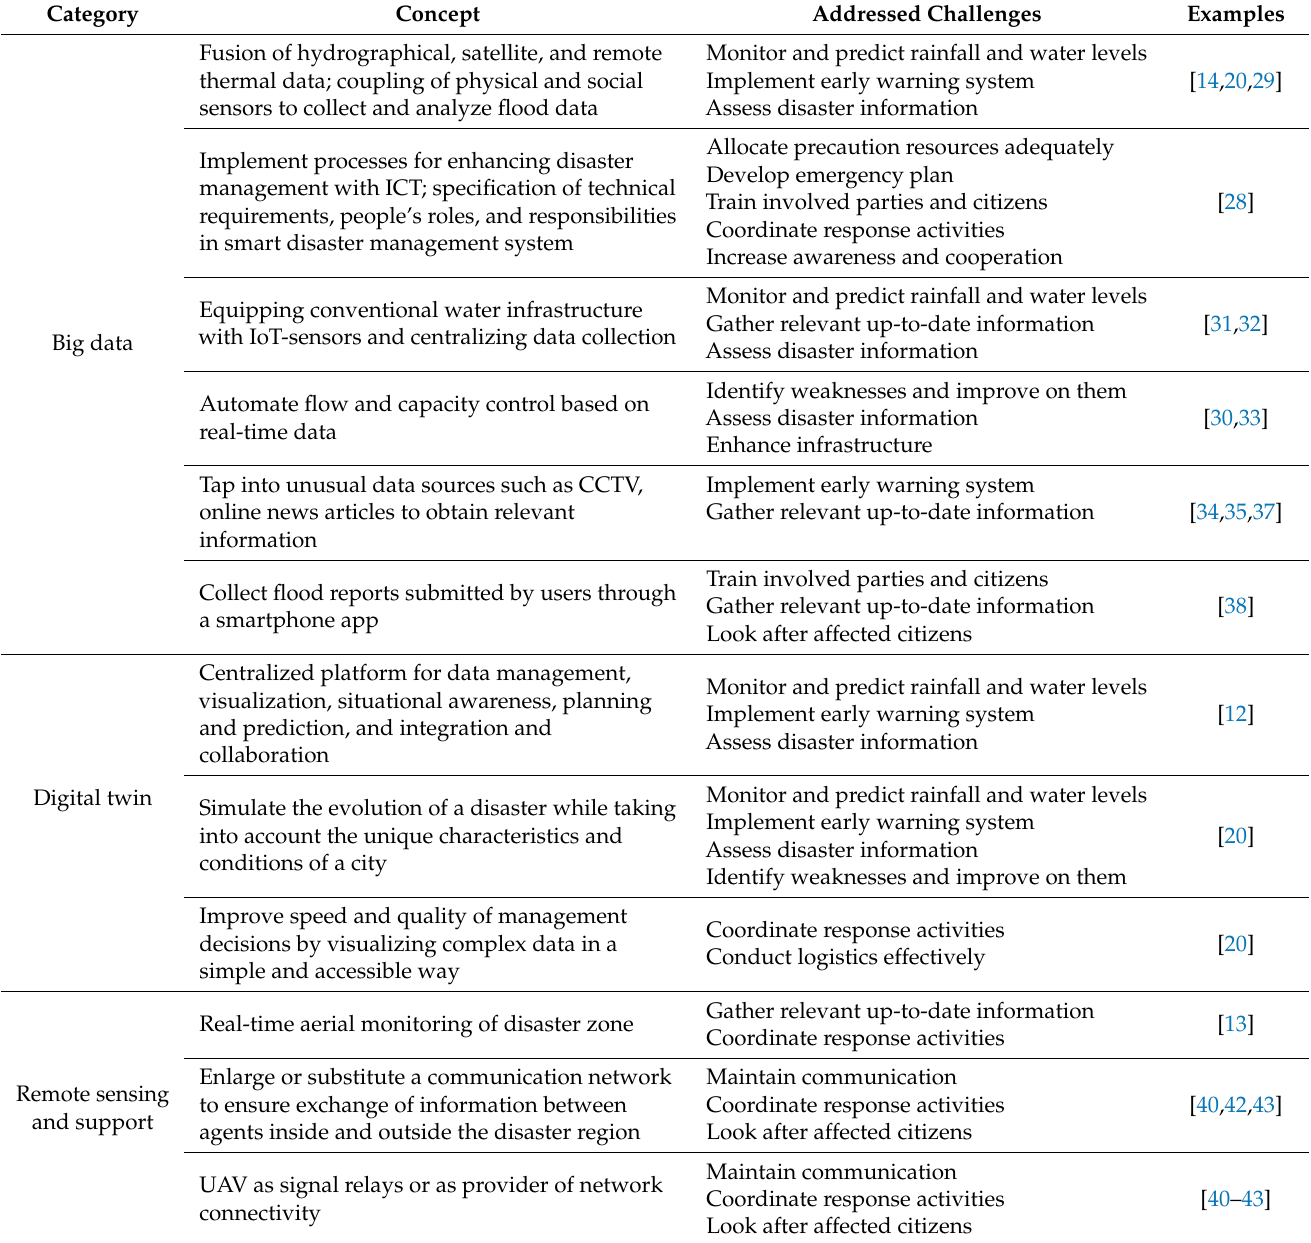
Table 4. Smart solutions address specific challenges of flood